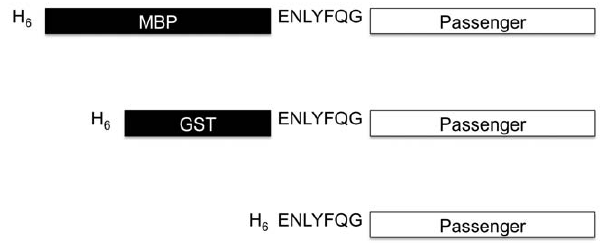
Figure 1. Design of fusion proteins. Schematic representation of fusion proteins with three different N-terminal tags: H 6 , H 6 -GST, and H 6 - MBP (not to scale). In the tagged forms of TEV protease, the canonical TEV protease recognition site (ENLYFQG) was replaced by an uncleavable recognition site ENLYFQP [21] to prevent autodigestion of the fusion proteins.